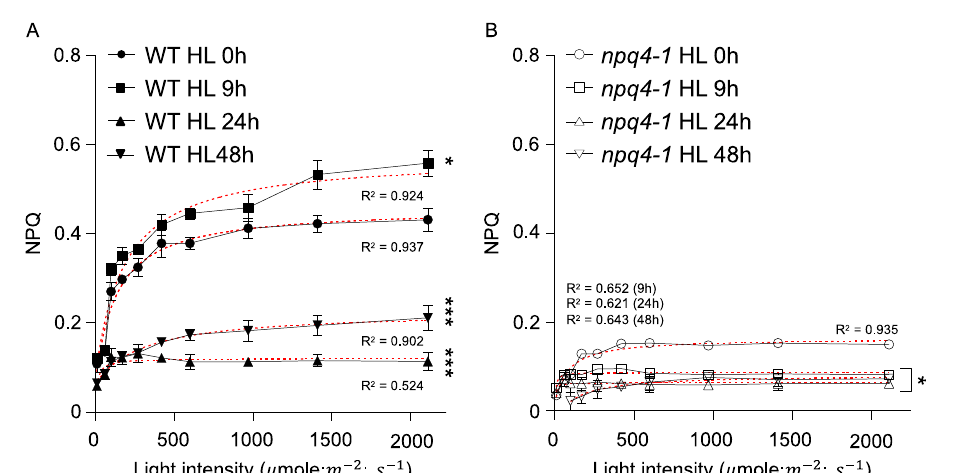
Figure 2. Light response curves for non-photochemical quenching in wild-type and npq4-1 mutants during high light illumination. Leaves of 4-weeks-old seedlings grown in a growth chamber were treated with high light (HL) at 700 μ mol photons m − 2 s − 1 for 0, 9, 24, or 48 h and dark-adapted for 10 min before the measurement of non-photochemical quenching (NPQ). Each photosynthetically active irradiance of 0, 70, 110, 180, 250, 400, 550, 900, 1400, or 2200 µ mol photons m − 2 s − 1 was applied for 10 min for the measurement in ( A ) WT; and ( B ) npq4-1 mutant leaves. NPQ was calculated as described in Section 4. Each point represents the mean of at least four experiments (SD indicated by the bar). Regression line plotted as red dashed line estimated via nonlinear least square regression. R 2 denotes the regression coefficient. Significance differences of fitted curves are indicated by asterisks (* p < 0.05; *** p < 0.001) compared to the 0 h as determined by one-way ANOVA with Fisher’s LSD test.